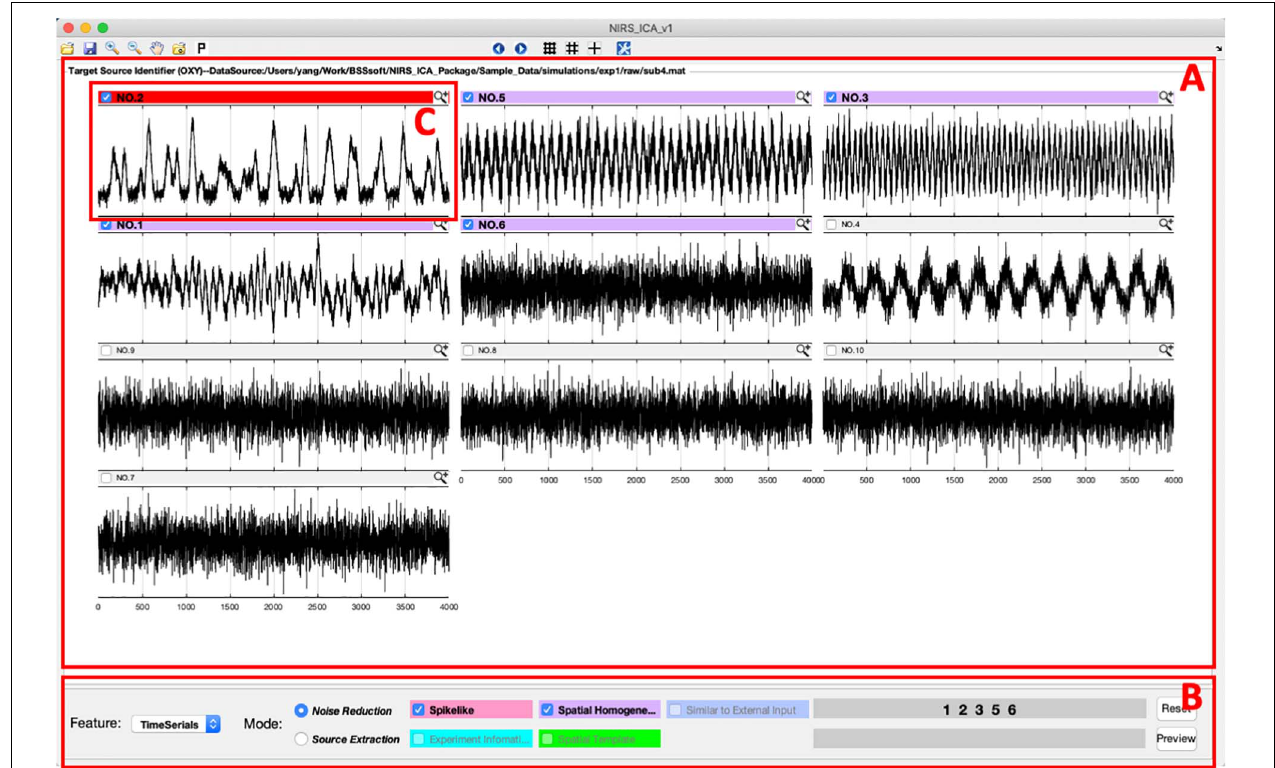
FIGURE 3 | The interface of sources selection according to their time courses. (A) Sources displaying panel in which time courses of sources are depicted in a grid manner. (B) Displaying control panel for changing features, modes, or orders of displayed time courses. (C) A representative spike-shaped source is marked as a noise-related